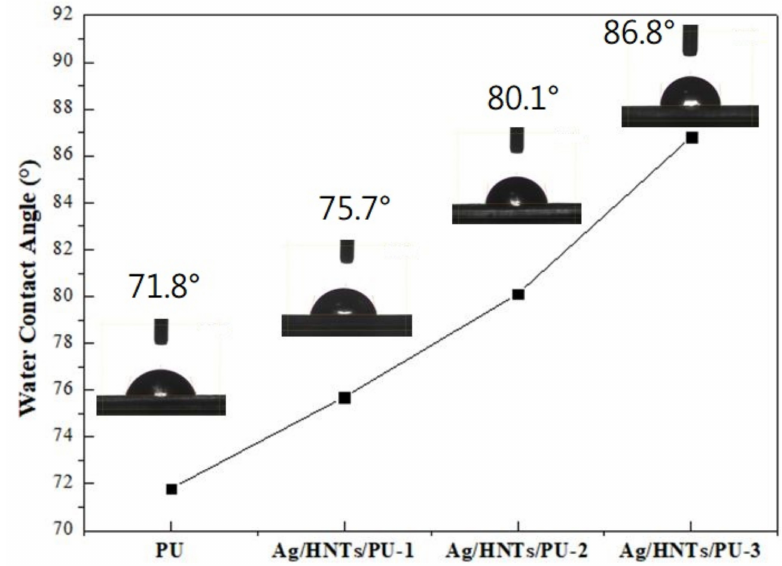
Figure 11. Water contact angle (WCA) trend chart of Ag / HNTs /